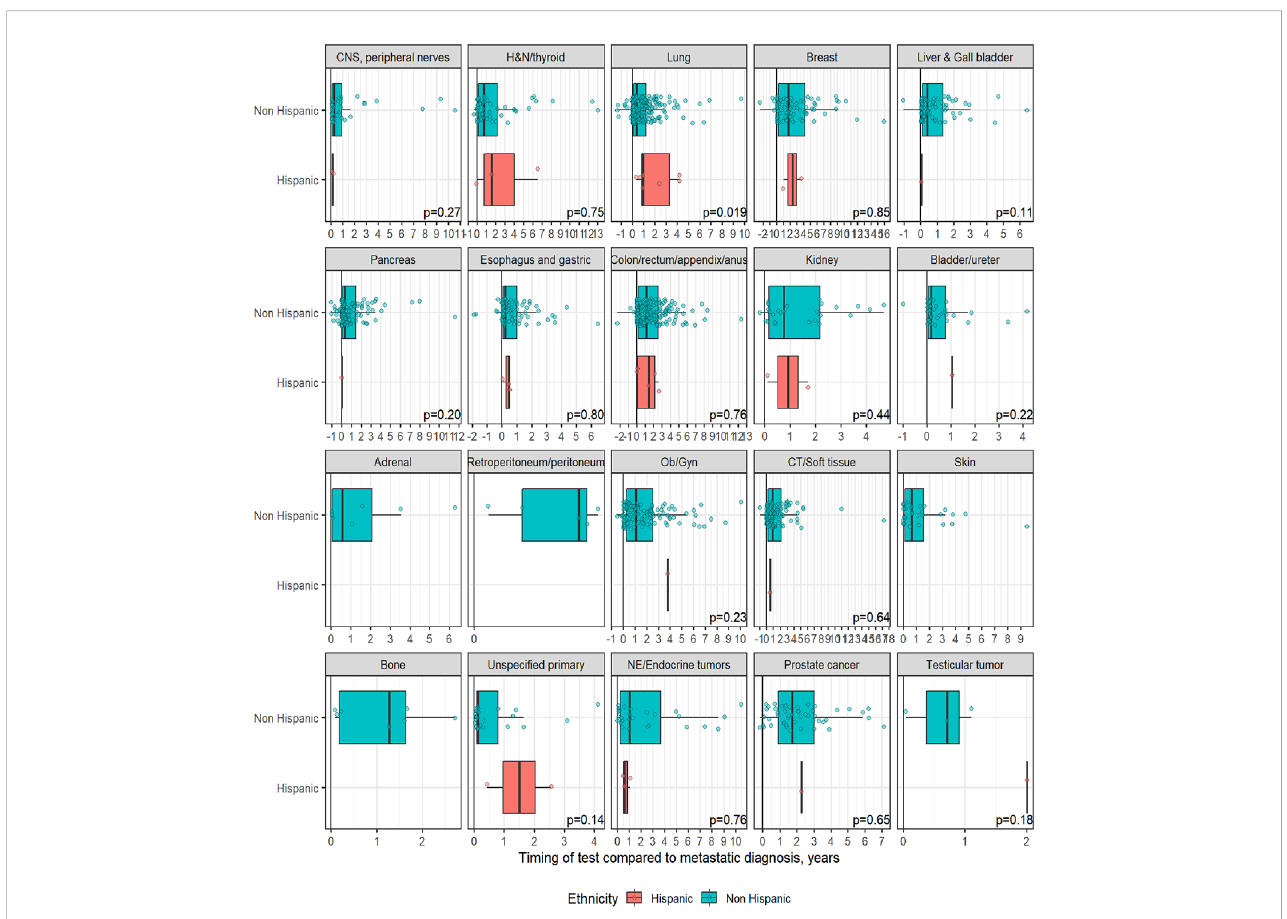
FIGURE 3 Effect of ethnicity on timing of comprehensive genomic pro fi ling (CGP) test after adjusting for diagnosis. No signi fi cant difference in timing of CGP test observed except for lung